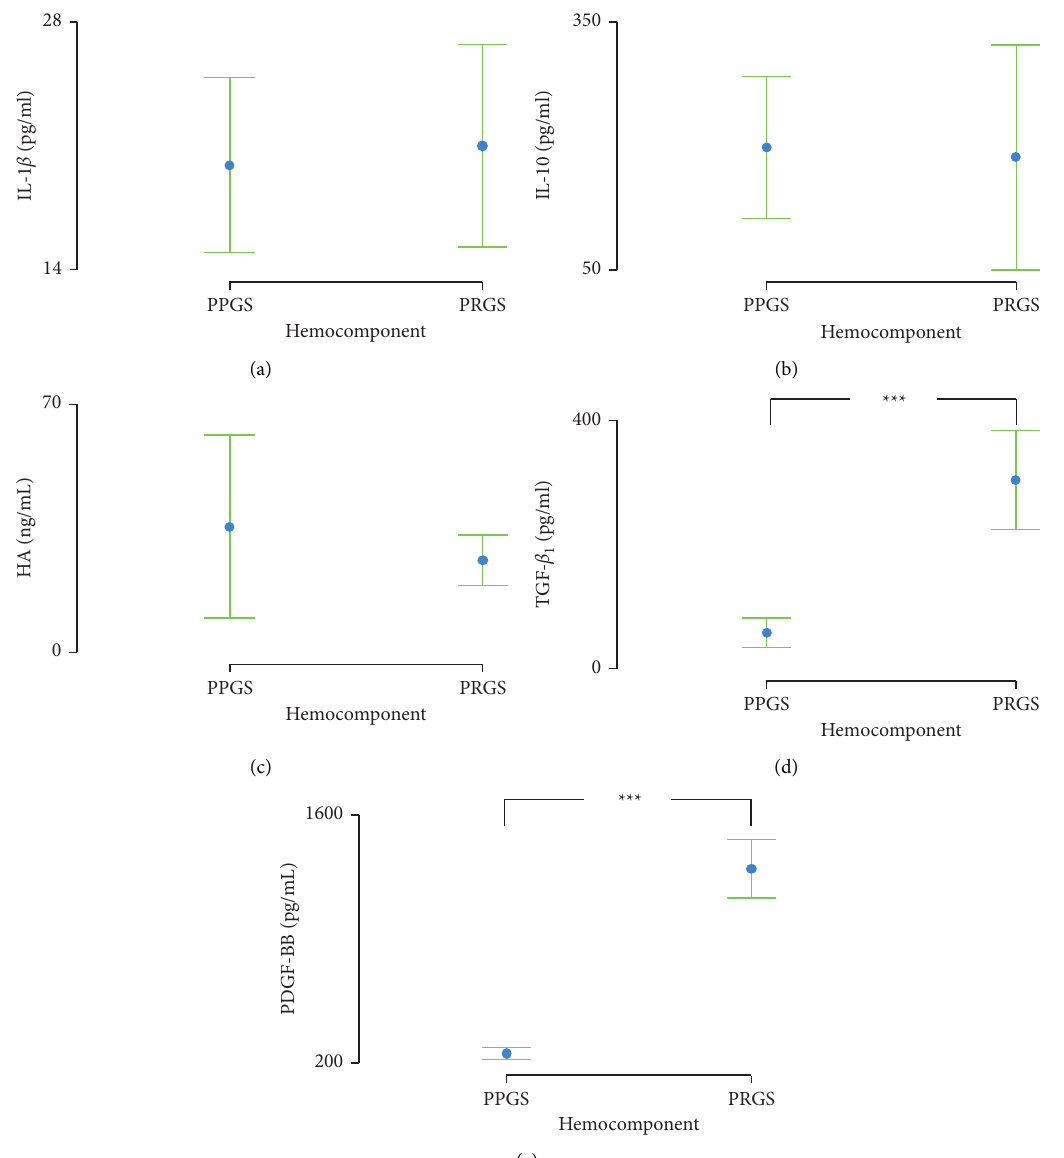
Figure 3: Biomolecule concentrations in both hemocomponents, platelet-poor gel supernatant (PPGS), and platelet-rich gel supernatant (PRGS). (a) Mean ( ± SD) interleukin 1 beta (IL-1 β ) concentrations in PPGS and PRGS. (b) Mean ( ± SD) interleukin 10 (IL-10) con- centrations in PPGS and PRGS. (c) Mean ( ± SD) hyaluronan (HA) concentrations in PPGS and PRGS. (d) Mean ( ± SD) transforming growth factor beta 1 (TGF- β 1 ) concentrations in PPGS and PRGS. (e) Mean ( ± SD) platelet-derived growth factor isoform BB (PDGF-BB) concentrations in PPGS and PRGS. Different lower-case letters represent significant ( P < 0 . 05 ) differences between hemocomponents for biomolecules. HA, hyaluronan; IL, interleukin; LPS, lipopolysaccharide; PLT, platelet; PDGF-BB, platelet-derived growth factor isoform BB; PPP/PPGS, platelet-poor plasma/platelet-poor gel supernatant; PRP/PRGS, platelet-rich plasma/platelet-rich gel supernatant; TGF- β 1 , transforming growth factor beta 1; WBC, white blood